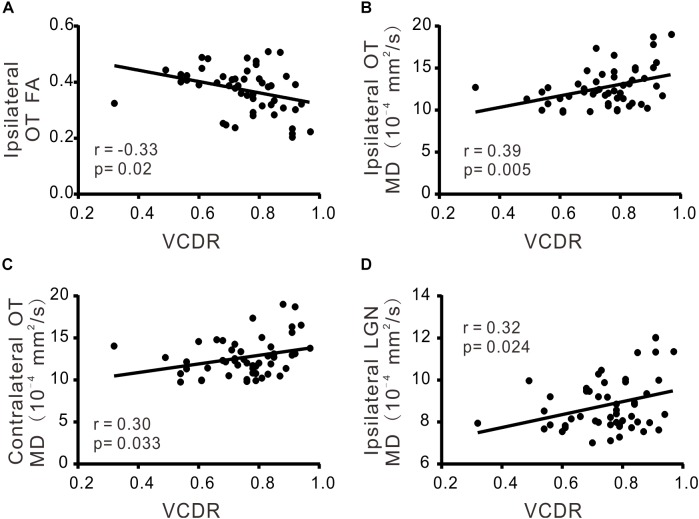
The correlations of DTI parameters and VCDR. FA (A) and MD (B) in ipsilateral OT, MD in contralateral OT (C), MD in ipsilateral LGN (D) were significantly correlated with VCDR.